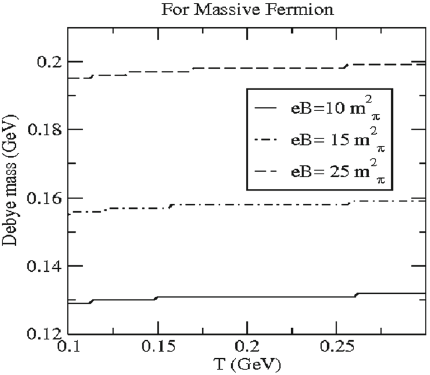
Fig. 2 The effect of the temperature is only pronounced at low tem- perature and high magnetic field